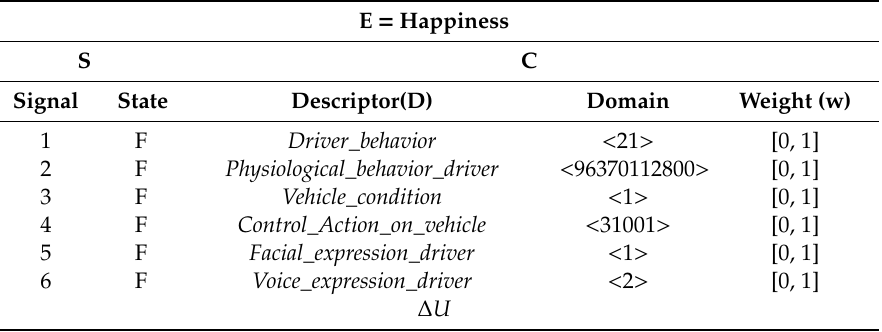
Table 7. Module of recognition of emotions.